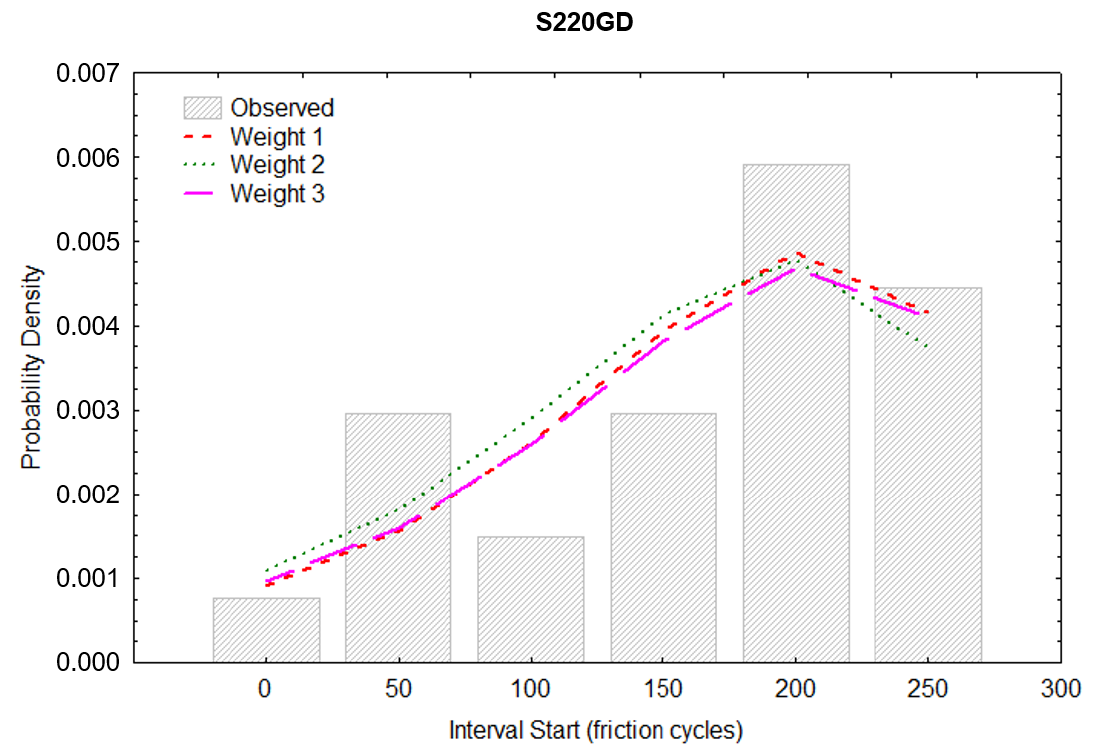
Figure 16. Probability density of the wear of the S220 coating.